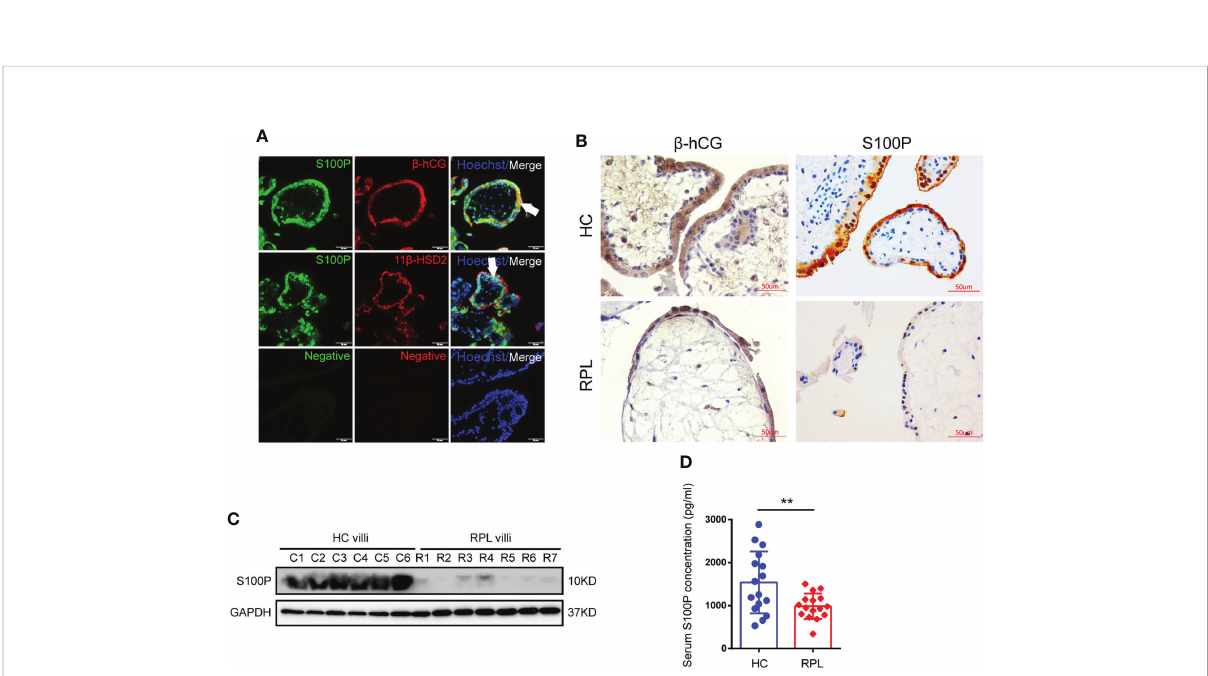
FIGURE 2 Placenta and serum S100P levels in healthy controls and RPL patients. (A) Immuno fl uorescence staining of S100P (green), 11 b -HSD2 (red), b -hCG (red) and Hoechst staining (blue) in human healthy placentas (sixth to eighth week of gestation). White arrows indicate STB. Representative images from three independent experiments are shown. Scale bar, 50 m m. (B) Immunohistochemistry staining of S100P in human placentas extracted from women at six- to-eight weeks of gestation. b -hCG was used to identify syncytiotrophoblast layers. Scale bars, 50 m m. (C) Representative Western blotting of S100P expression in normal and RPL placental tissues (Ctrl n=6 vs. RPL n=7). (D) Measurement of serum S100P levels in healthy controls and RPL patients by ELISA (n=16). ** p =0.0079.